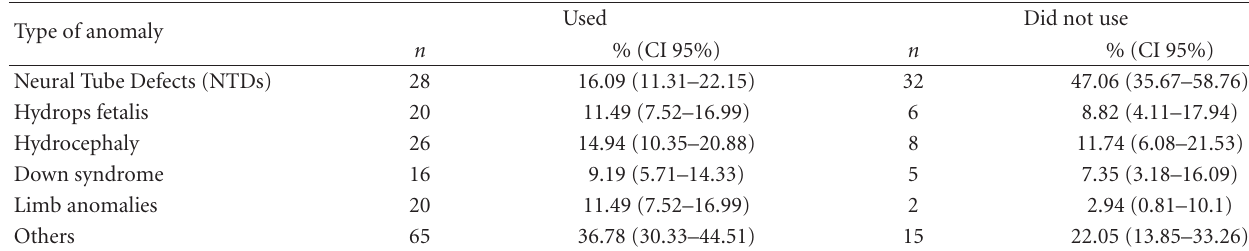
Table 1: Folic acid and type of